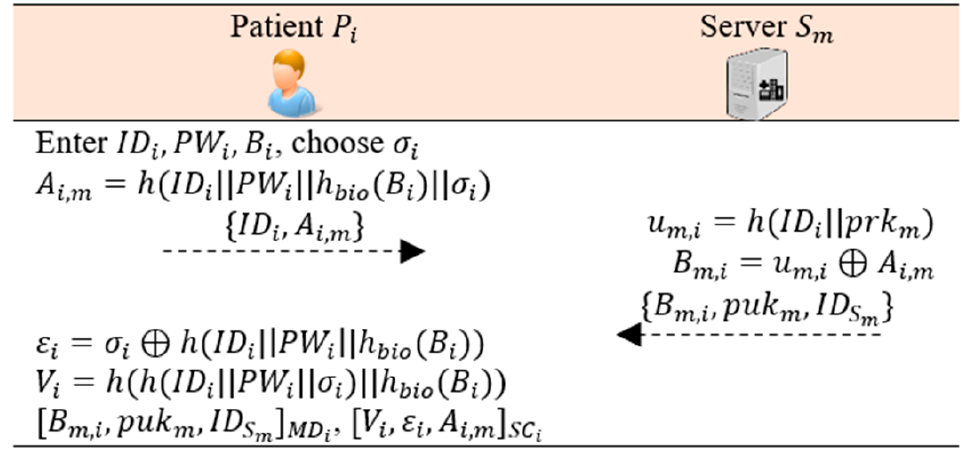
Figure 2. Registration procedure of the proposed